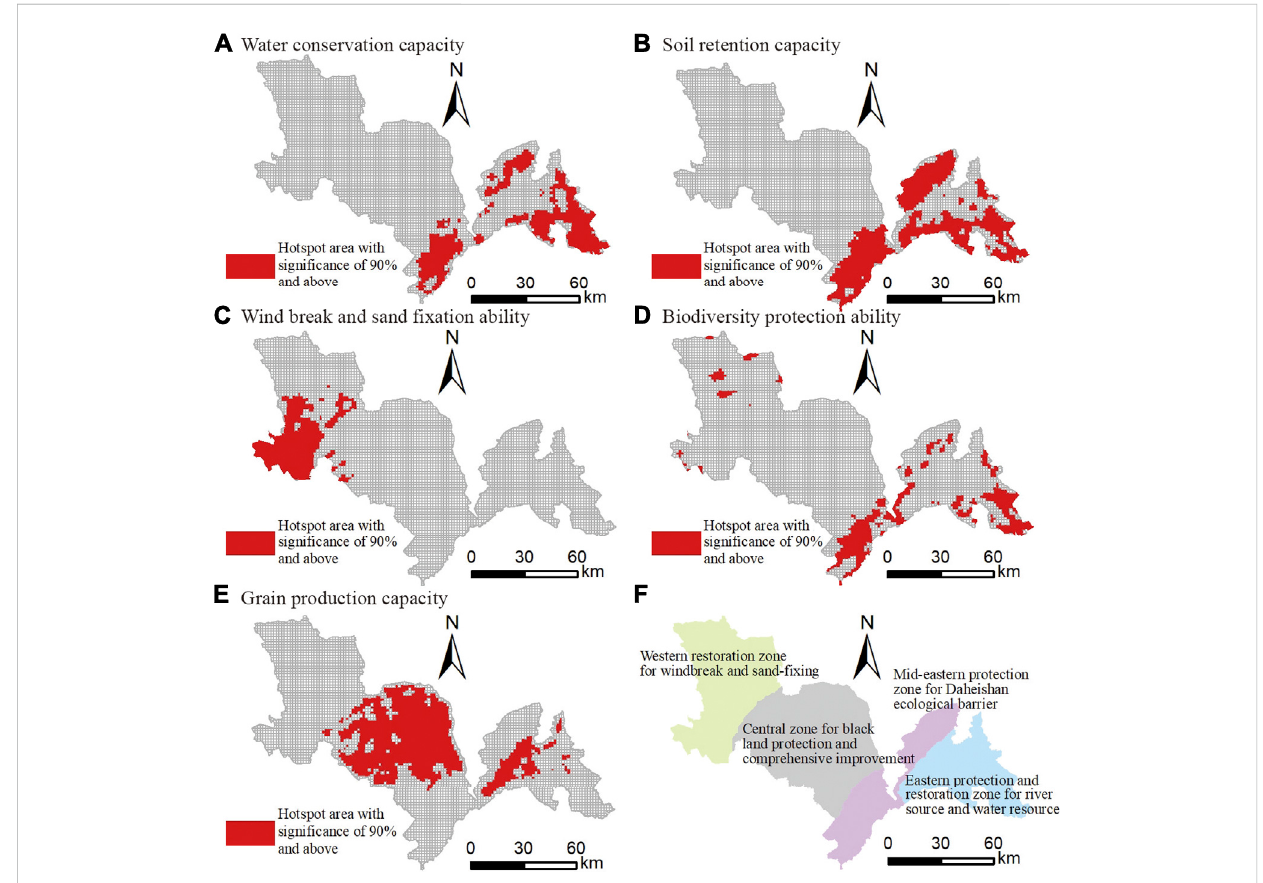
FIGURE 8 (A – E) Hotspot distribution of fi ve types of ecosystem services and (F) ecological restoration